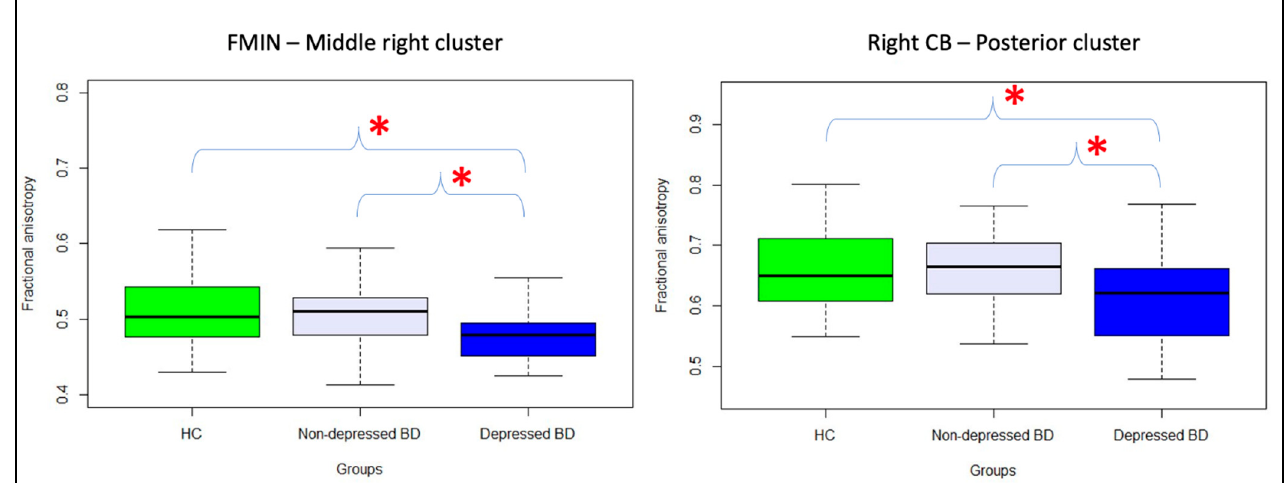
Figure 3. Neural predictors of future recurrence of depressive episodes in BD. Boxplots in panels A and B show the group difference upon FA in 39 HCs (green color), 33 BD participants without re- currence of depressive episodes after scan (Non-depressed BD, light blue color), and 19 BD partici- pants who showed recurrence of depressive episodes after scan (Depressed BD, blue color). Braces and asterisks show p -values that survived FDR correction. Abbreviations: FMIN, Forceps Minor; CB, Cingulum